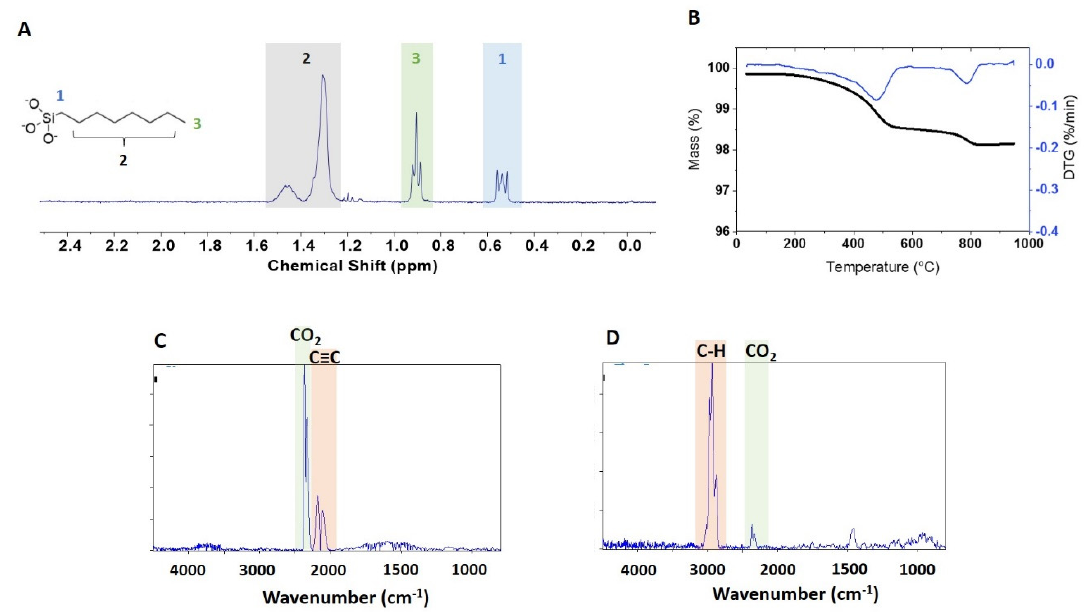
Figure 4. Characterisation of caprylsilane functionalized ZnO sample BASF-02-C8: ( A ) 1 H NMR spectra of caprylsiloxane moiety dissolved in 0.4 M NaOD in methanol-d 4 , ( B ) representative thermogram and ( C , D ) FT-IR spectra of evolved gases measured at 560 ˚ C ( C ) and 807 ˚ C ( D ).